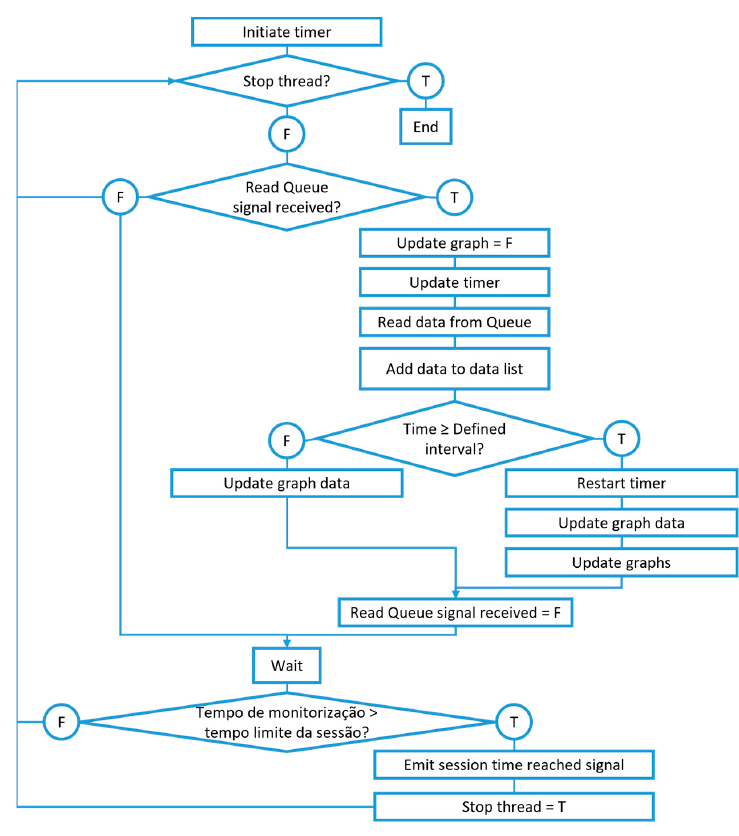
Figure 7. Graph thread code structure schematic.